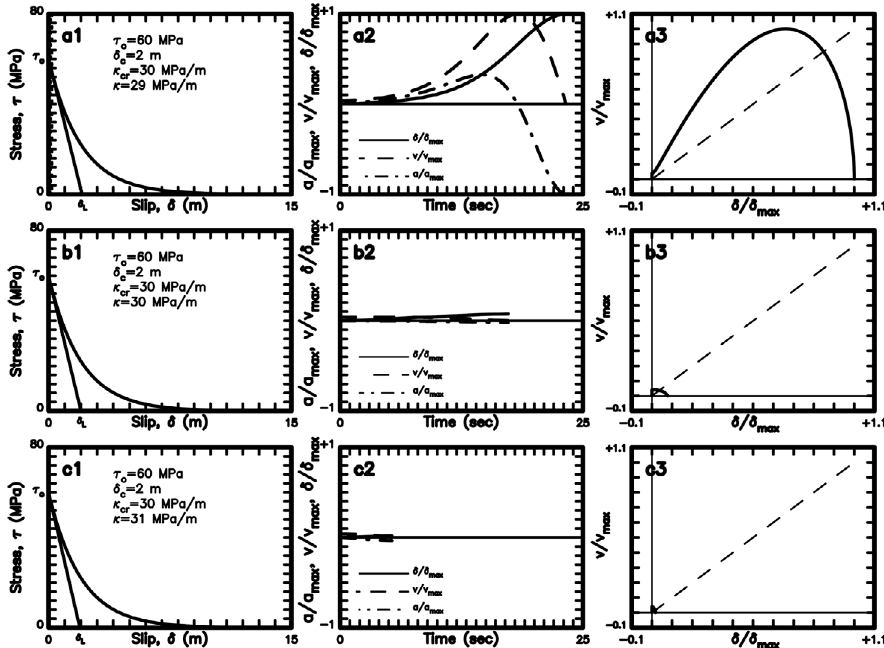
Figure 5. Numerical results to examine the detailed variations of motions from unstable to stable states when the values of l are close to l . (a) For l =29 MPa/m. (b) For l =30 MPa/m. (c) For l =31 MPa/m. 1, stress–slip functions; 2, temporal variations in a/a cr (dashed line), and d / d (solid line); 3, phase portraits for v/v ted line), v/v max max